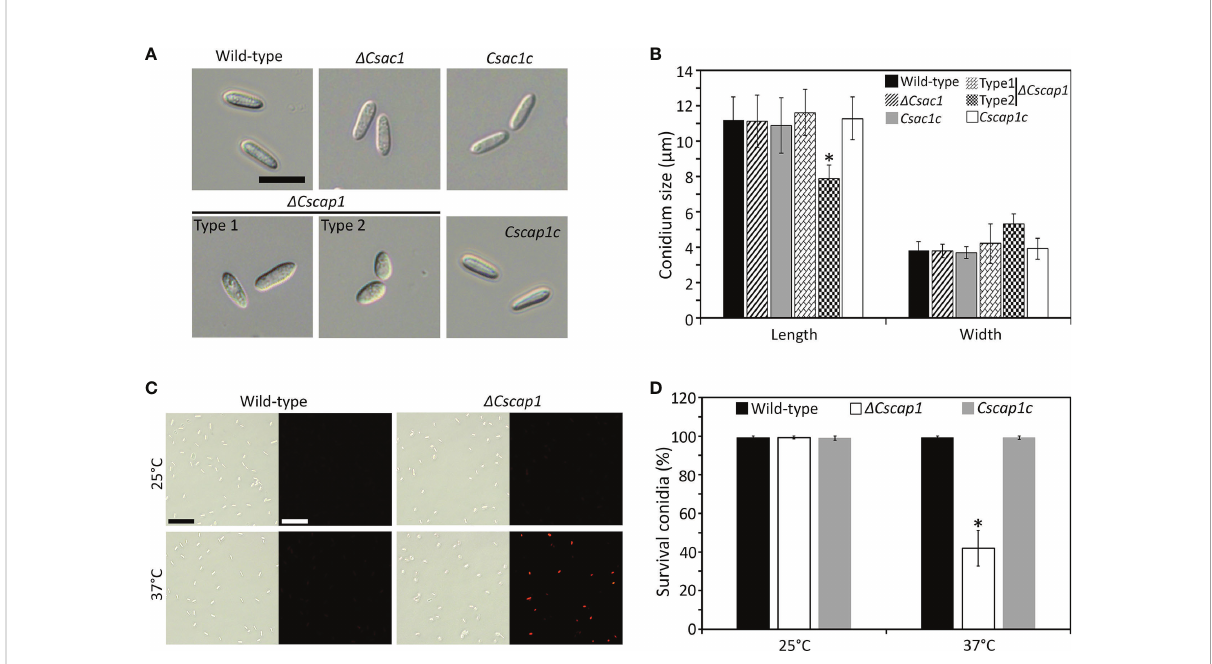
FIGURE 5 Roles of CsAc1 , CsCap1 , and CsPdeH in conidium morphology and conidium viability. (A, B) Visualization and measurement of conidium morphology. (A) Conidia were collected from 7-day-old OMA cultures using distilled H 2 O. Scale bar, 10 m m. (B) Length and width of 100 conidia. D Cscap1 produced two types (types 1 and 2) of conidia. (C, D) Conidium viability under heat shock. (C) Conidia stained with phloxine (B) Conidia of the indicated strains were incubated at 25°C or 37°C for 16hours and stained with phloxine (B) Survival is indicated by red fl uorescence. Scale bar, 50 m m. (D) Quantitation of conidium survival (n = 100 conidia). Error bars show standard deviations and asterisk (*) indicates a signi fi cant difference estimated using Duncan ’ s test (P <